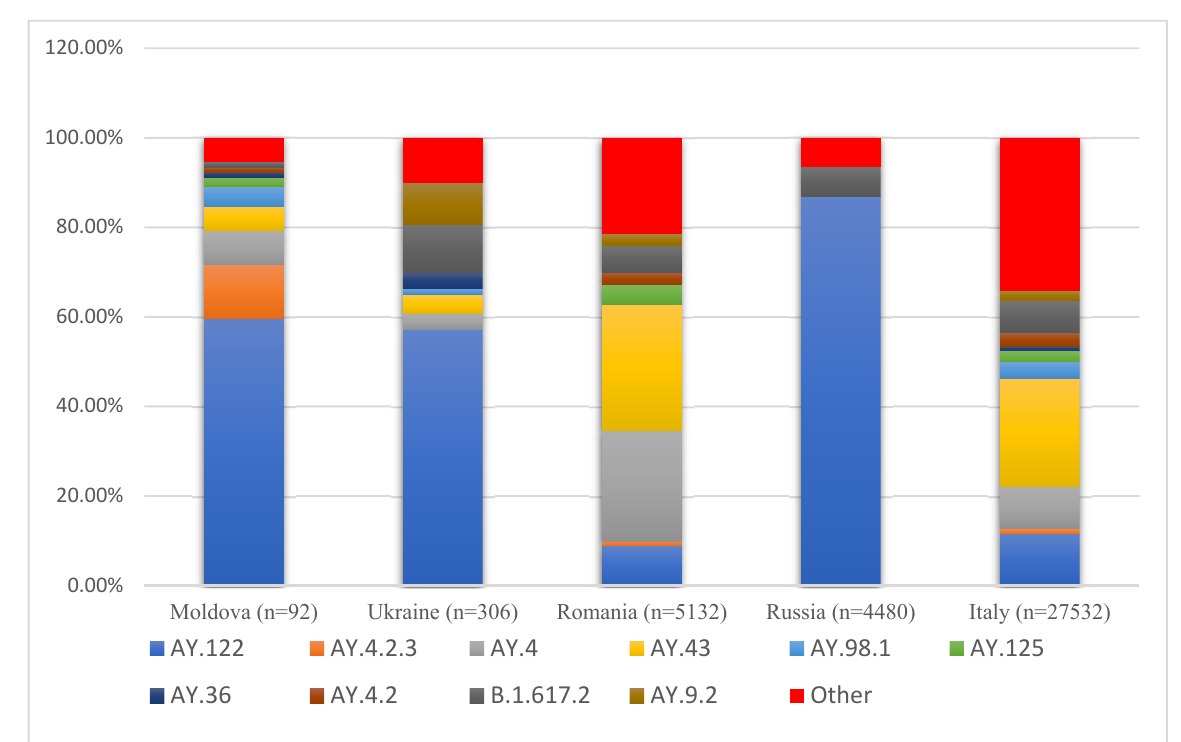
Figure 2. Distributions of SARS-CoV-2 lineages in the period August–November 2021.